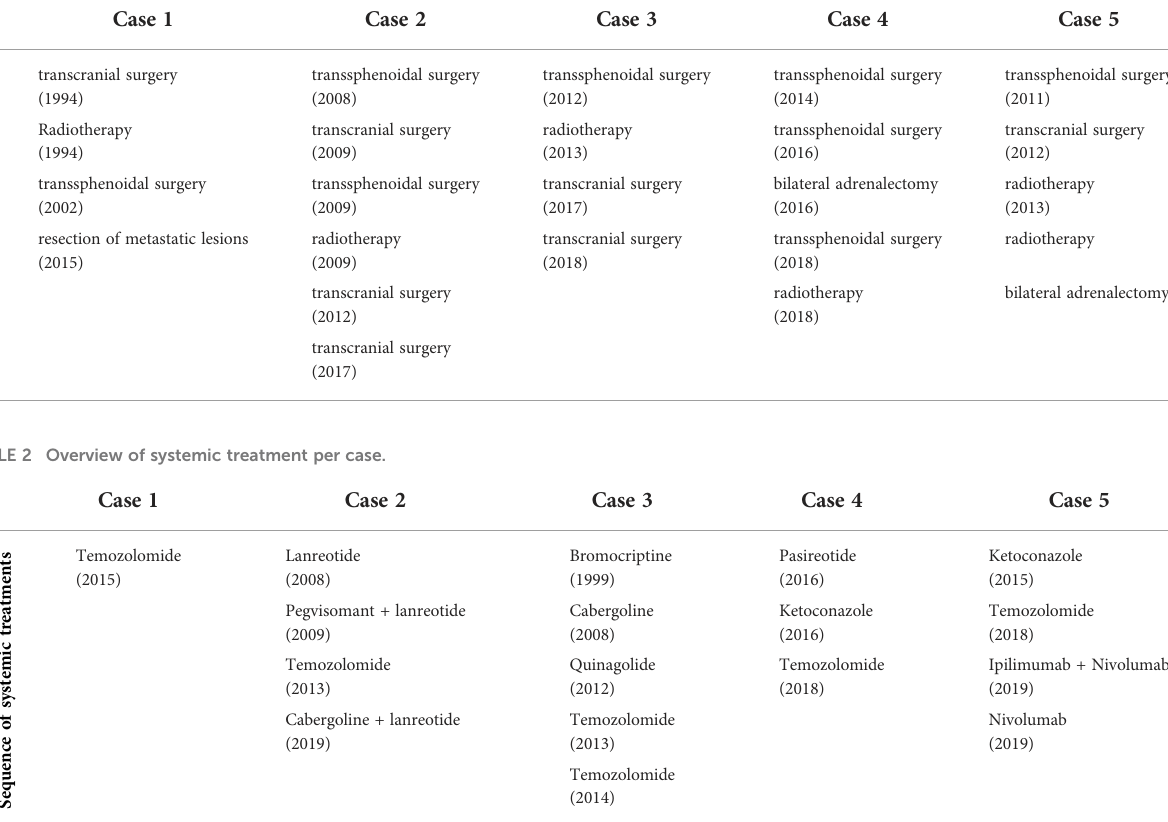
TABLE 1 Overview of the different local treatments including, surgery, radiotherapy and adrenalectomy.